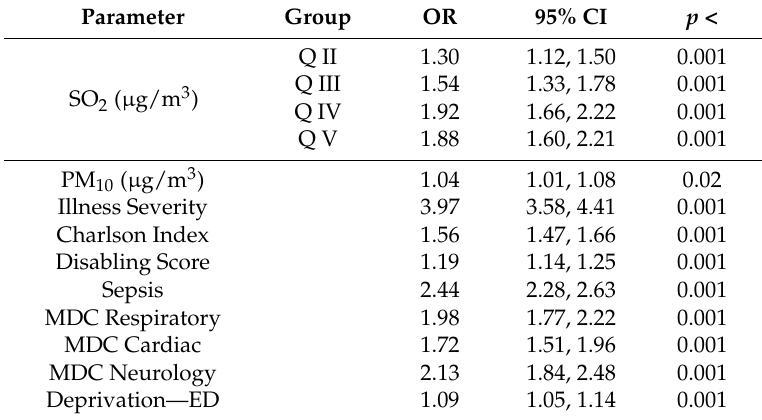
Table 1. Logistic multivariable model of 30-day in hospital mortality related to admission levels of PM 10 and SO 2 , with adjustment for other risk